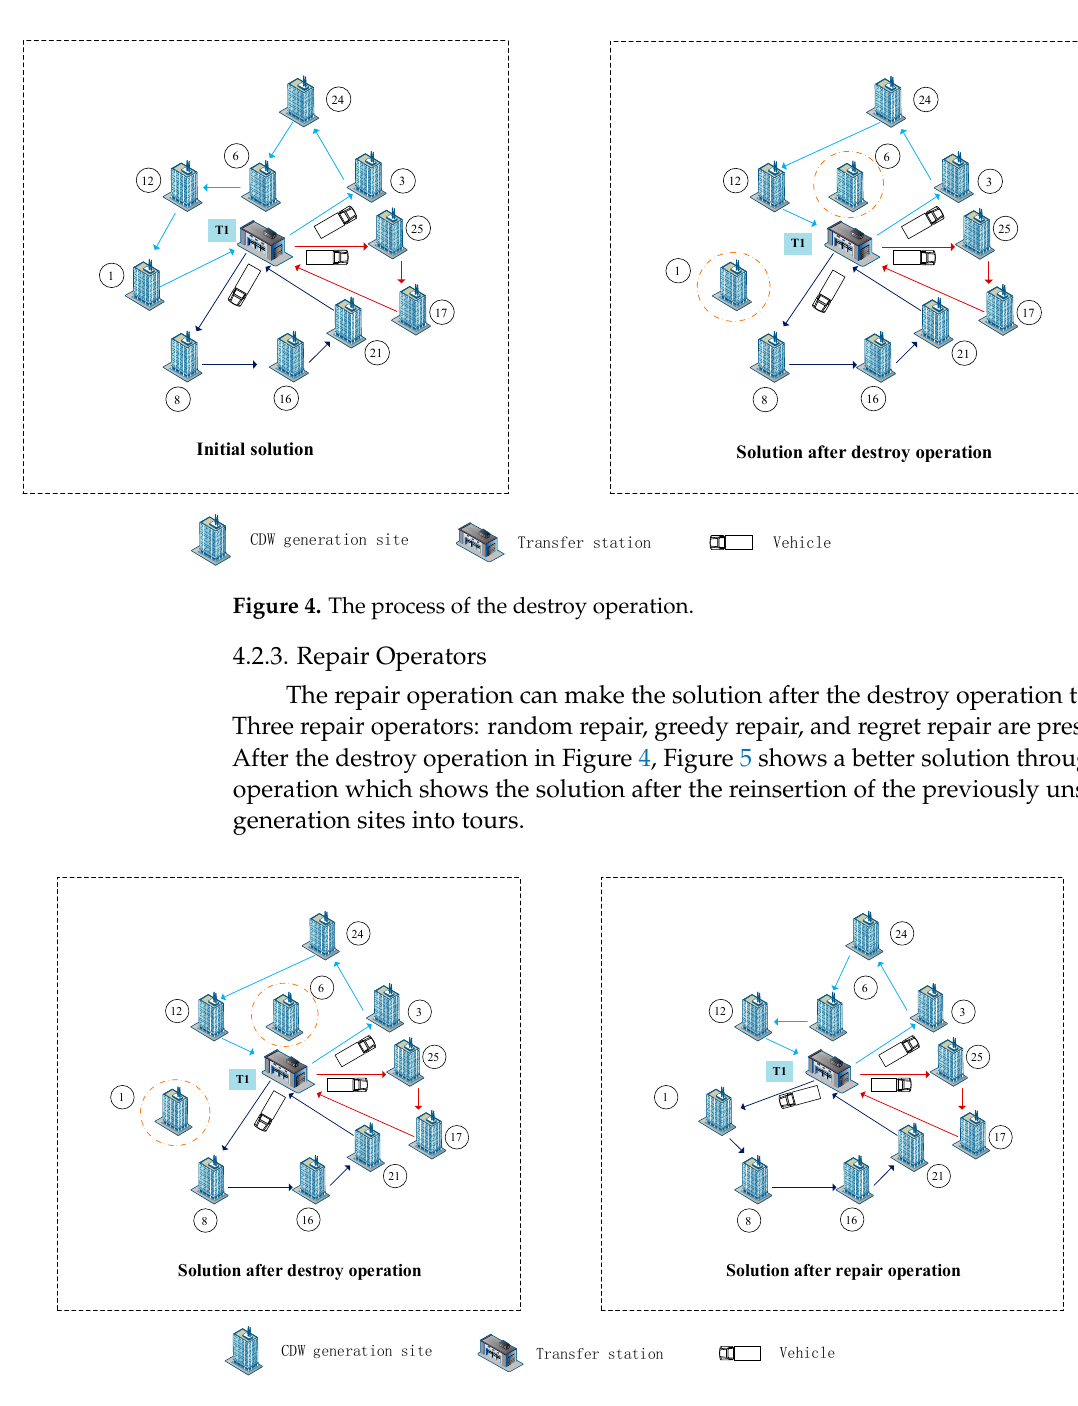
Figure 5. The process of the repair